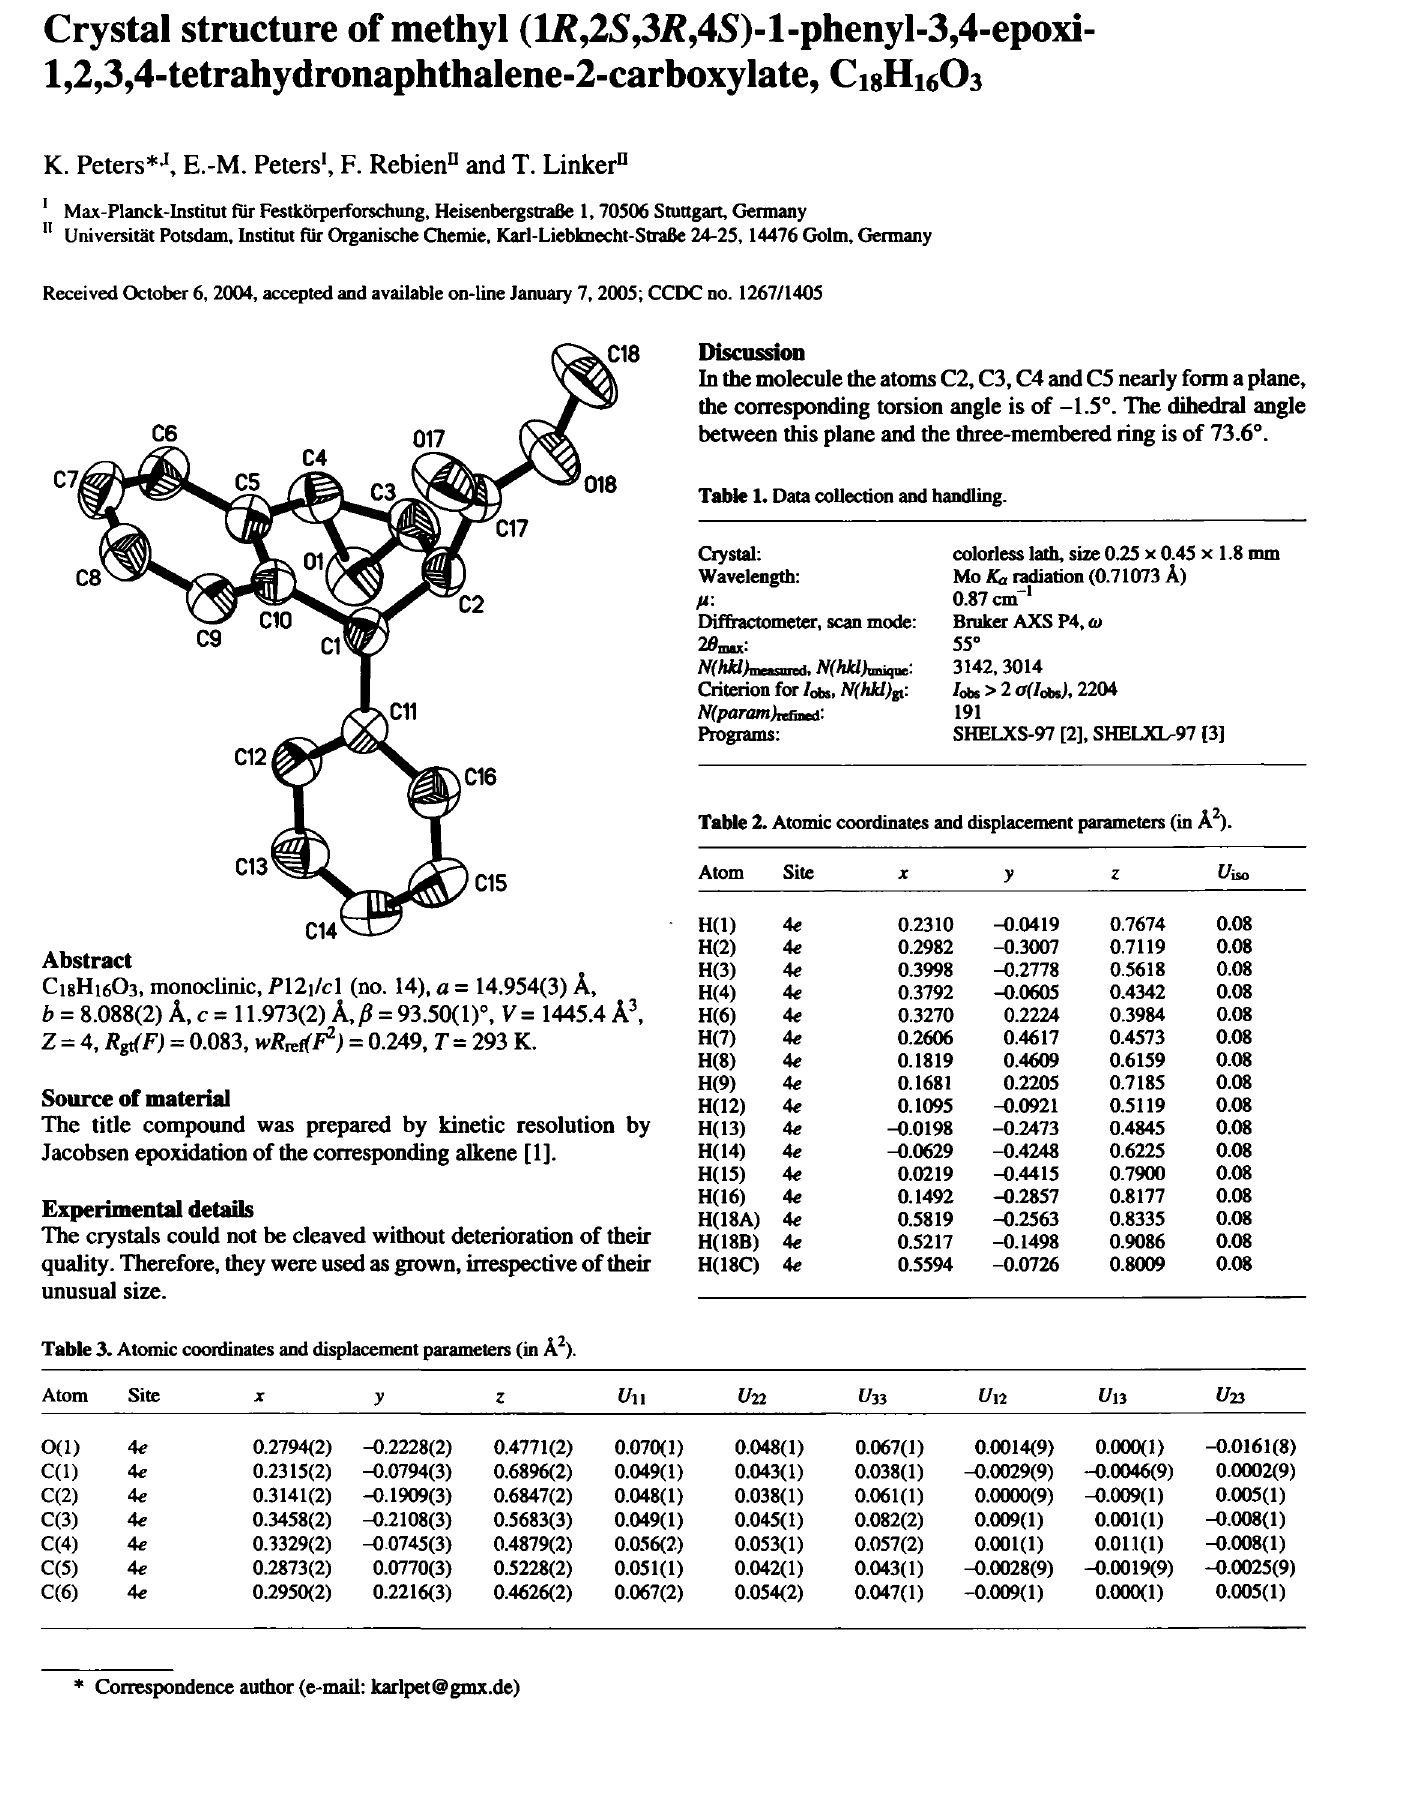
Table 3. Atomic coordinates and displacement parameters (in A 2